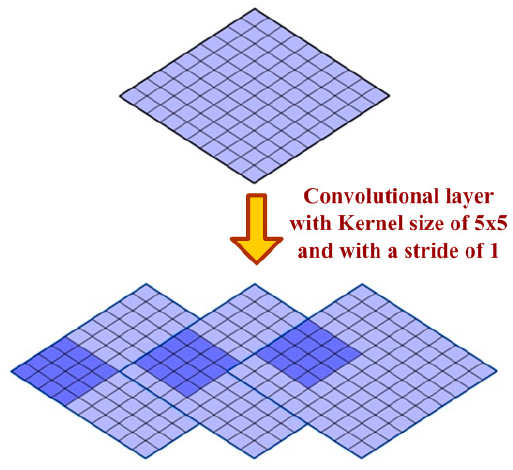
Figure 4. Representation of kernel and stride in a convolutional layer.